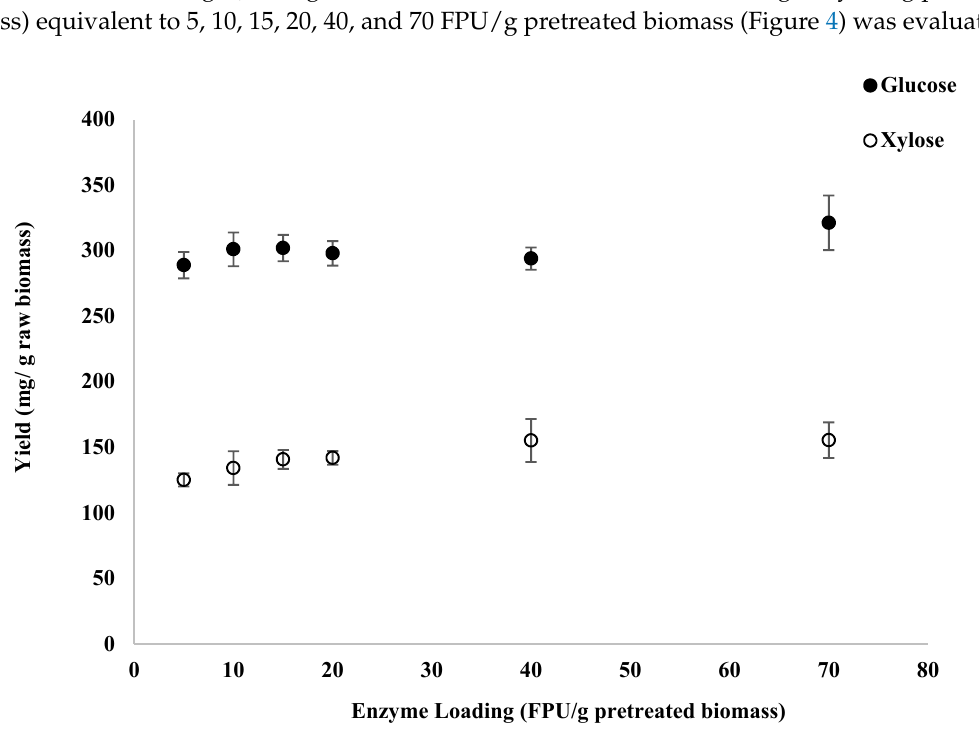
Figure 4. Glucose and xylose yield after enzymatic hydrolysis of switchgrass treated at 1.0% NaOH for 30 min with varying doses of CTec2 and HTec2.